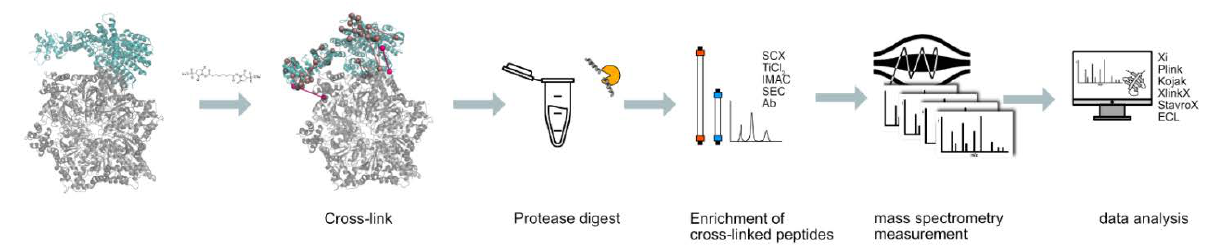
Figure 2. Workflow of a CLMS analysis. The protein or protein complex of interest is cross-linked, followed by protease digestion to generate peptides suitable for mass spectrometric analysis. This is followed by an enrichment step for cross-linked peptides, which are in turn sequenced by mass spectrometry. The resulting spectra are interpreted by specialized software packaged to reveal the location of the cross-linked peptides on the protein/complex structure.